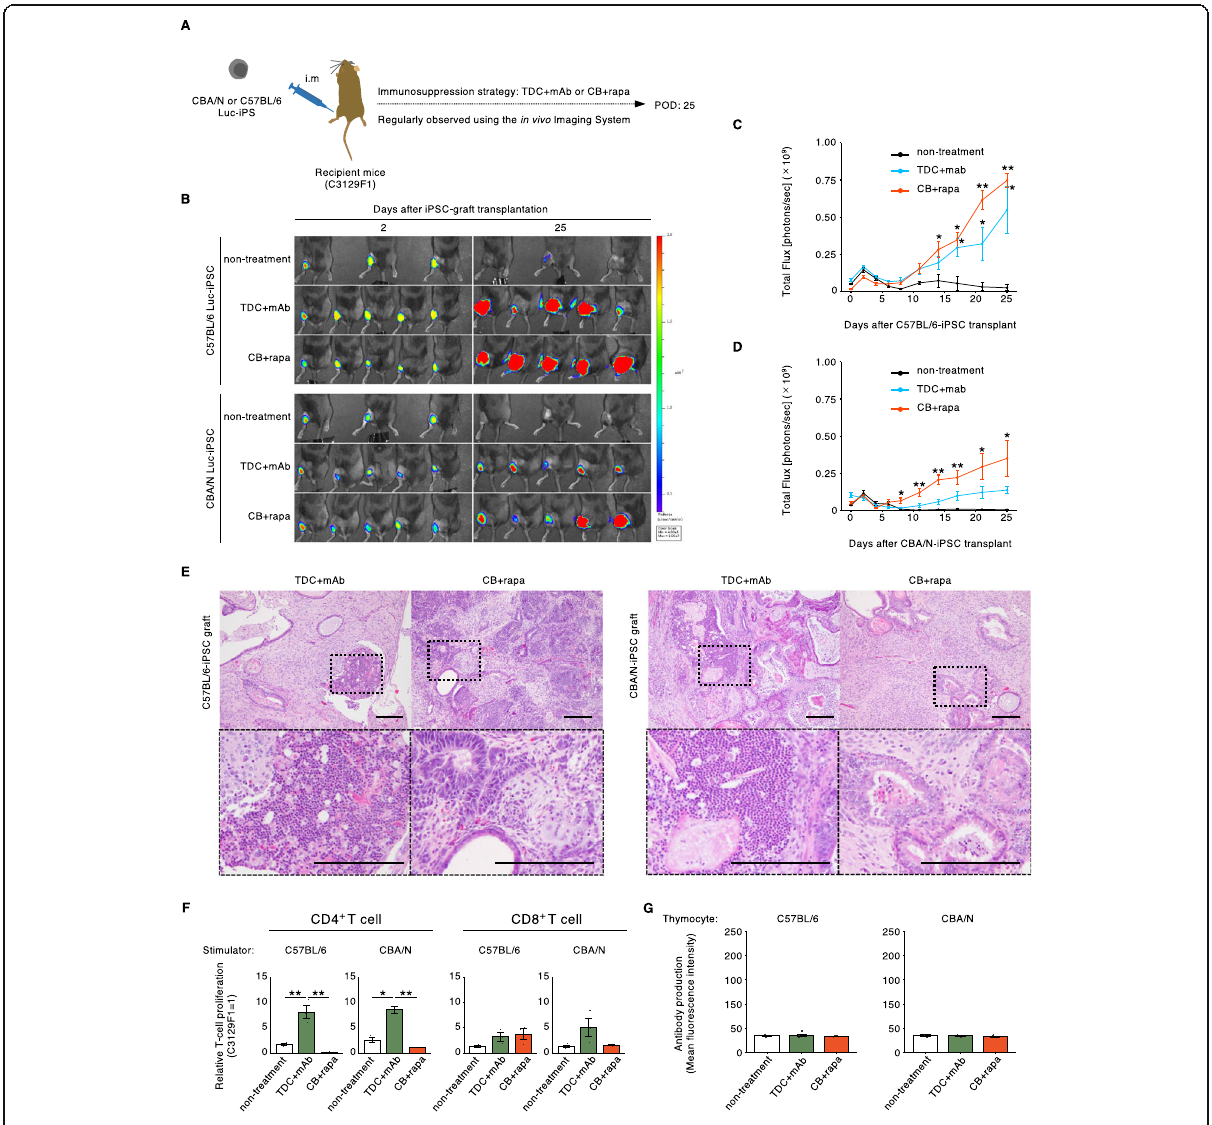
Fig. 3 Co-stimulatory blockade effectively prevents rejection to iPSC-grafts. ( A ) Schematic overview of CBA/N or C57BL/6 Luc-iPSC transplantation. ( B ) Bioluminescence images of C57BL/6 (upper panels) or CBA/N (lower panels) Luc-iPSC transplanted mice that received non-treatment, TDC + mAb, or CB + rapa. n = 3-5 per group. ( C , D ) Quantitative bioluminescence intensity of C57BL/6 ( C ) or CBA/N ( D ) Luc-iPSC-transplanted mice that received non- treatment, TDC + mAb, or CB + rapa. n = 3-5 per group. * p <0.05, ** p <0.01 (Tukey ’ s HSD test). ( E ) Hematoxylin and eosin stained sections of C57BL/6 (left panel) or CBA/N (right panel) Luc-iPSC-derived teratomas under immunosuppression with TDC + mAb or CB + rapa on day 35. Lower panels show enlargement of insets in the upper panels. Scale bars: 100 μ m. ( F ) Recipient T cell response in MHC-matched but minor antigen-mismatched iPSC transplantation. The T cell proliferation rates in each treatment group were normalized to that of C3129F1 mice stimulated with autologous irradiated splenocytes. Error bars indicate standard error of technical triplicates. Similar results were obtained in two independent experiments. * p <0.05, ** p <0.01 (Tukey ’ s HSD test). ( G ) De novo anti-donor antibody production in the recipients. Error bars indicate standard error of biological replicates ( n = 3, non- treatment; n = 5, TDC + mAb; n = 5, CB + rapa). Luc, luciferase; TDC, three drug combination; mAb, monoclonal antibody; CB, co-stimulatory